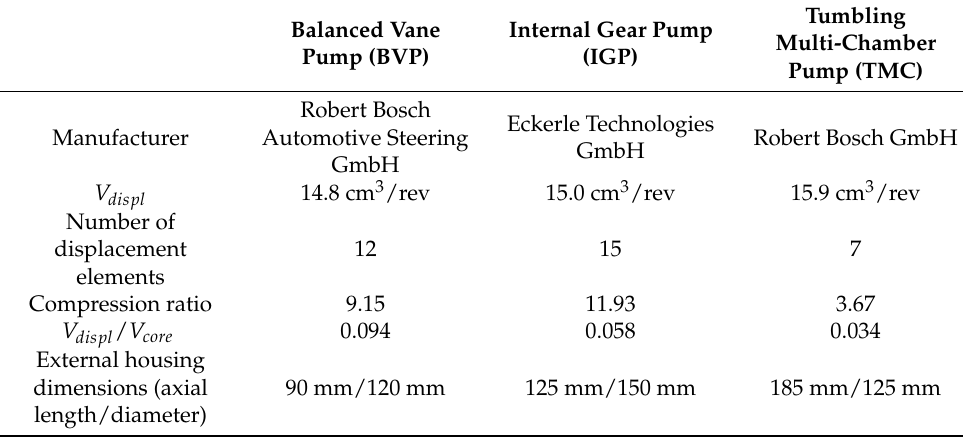
Table 1. Key properties and dimensions of the investigated